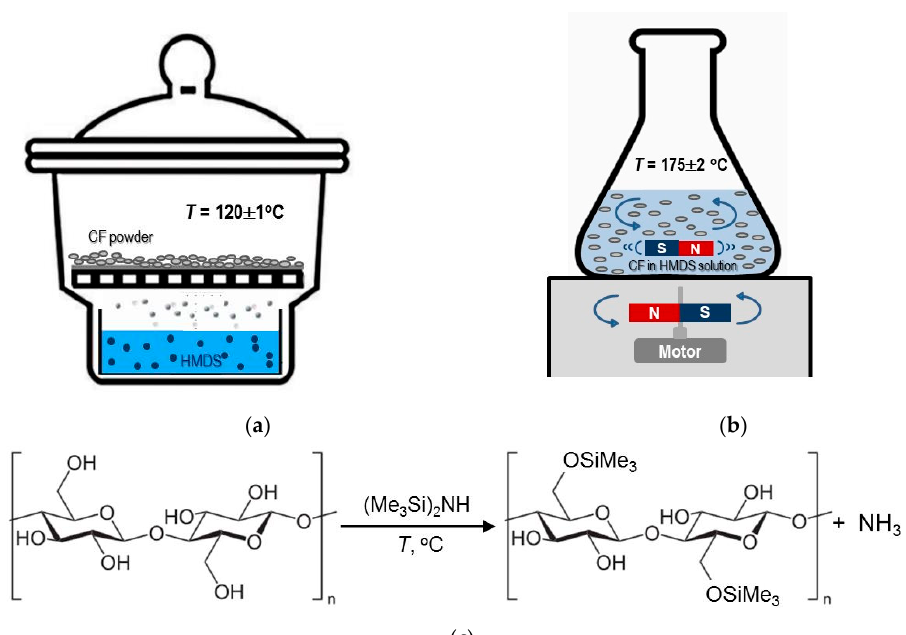
Figure 1. Silylation setups showing the treatment of cellulose microfiber surfaces with HMDS by ( a ) chemical vapor deposition and ( b ) modification from the liquid phase. ( c ) The scheme of cellulose silylation with HMDS.